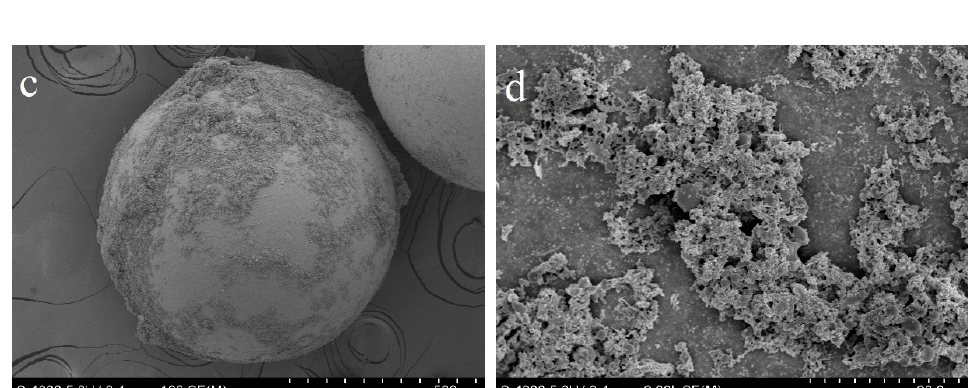
Figure 4. EDS spectrum of the CPS, ACPS, SLPS, and SLPS-P ( a – d ) and elemental mapping of Na, Si, and S of SLPS ( e – g ). The structural variation of the sodium lignosulfonate, CPS, ACPS, phenol, SLPS, and SLPS-P samples was examined by FTIR and the resulting spectra are illustrated in Figure 5. As can be seen from the figure, there is a broad peak of spectra at 3420 cm − 1 . This was caused by the stretching vibrations of the alcohols and phenolic hydroxyl groups associated with hydrogen bonds in the molecules. The adsorption peaks at 1593 and 1419 cm − 1 of the sodium lignosulfonate structure can be attributed to the skeleton vibration caused by the stretching vibration of carbon atoms in the benzene ring. It was indicated that there may be many binary substituents on the benzene ring of sodium lignosulfonate. The adsorption peaks at 1120 cm − 1 of the sodium lignosulfonate structure could have